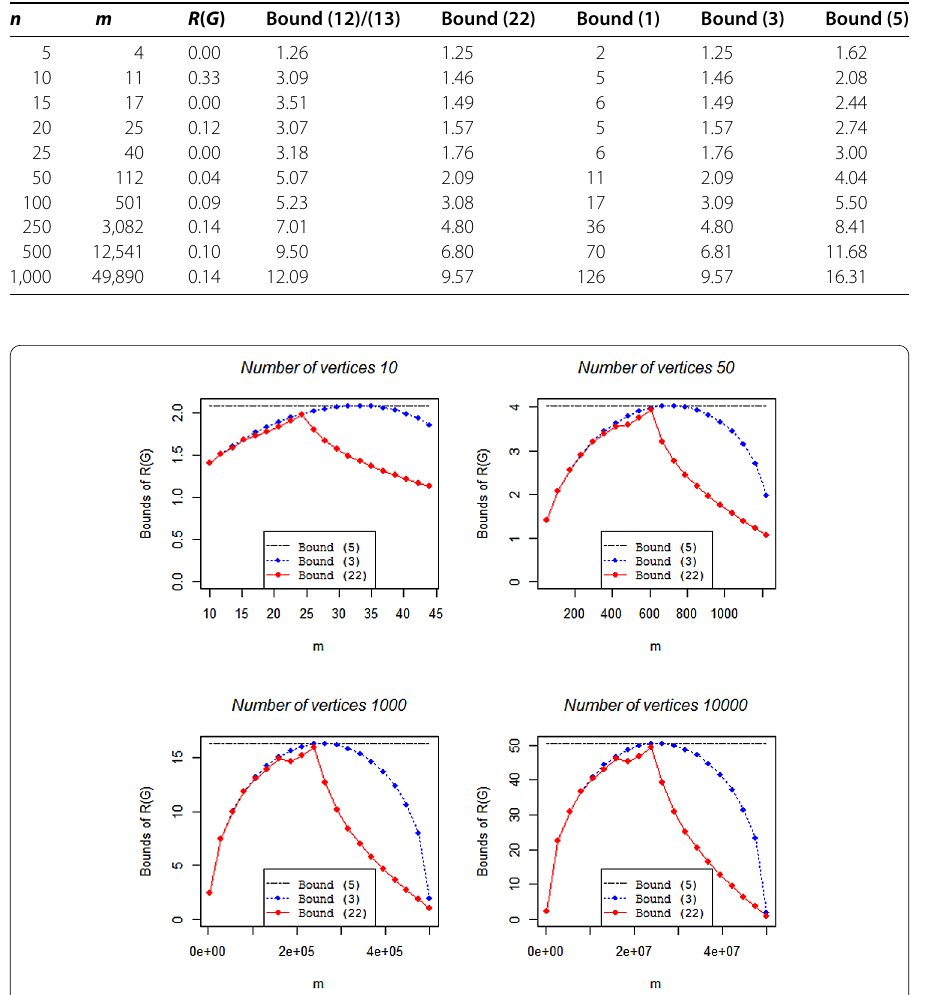
Figure 1 Upper bounds of R ( G ) for non-bipartite graphs with different number of vertices and